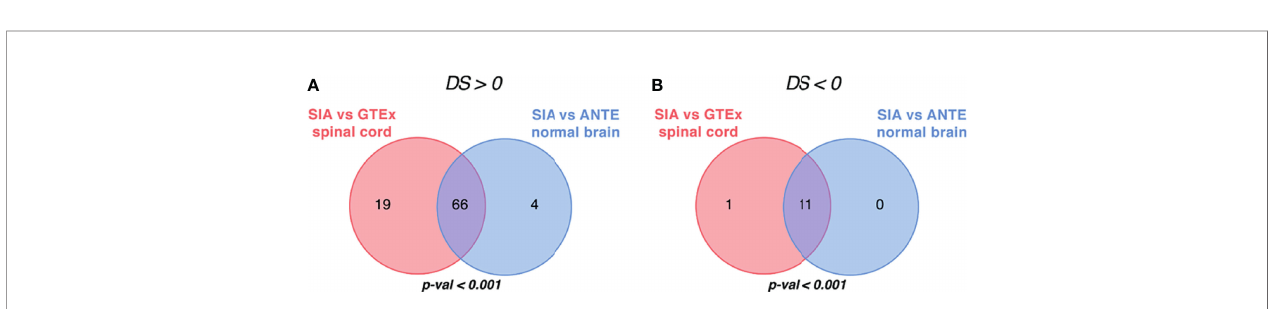
FIGURE 8 | Intersection of targeted therapeutics assessed by Oncobox algorithm with (A) positive and (B) negative drug score (DS) predicted for spinal intramedullary astrocytomas (SIAs) separately normalized on GTEx healthy spinal cord and on ANTE normal brain samples; p -values for intersection signi fi cance obtained in perturbation test are highlighted in bold.